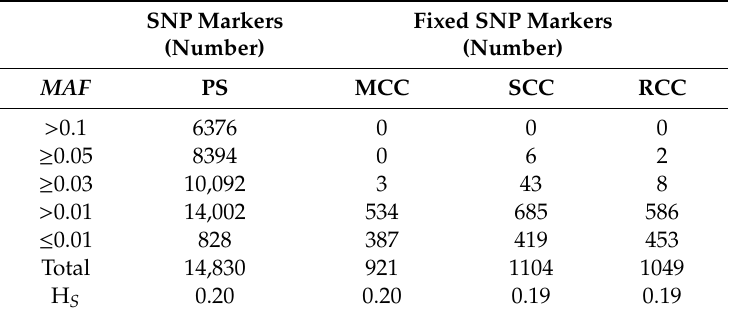
Table 5. Genetic diversity (H s ) and distribution of minor allele frequency (MAF) for the SNP (Single Nucleotide Polymorphisms) markers in the primary set and those fixed in the core collections. SNP Markers (Number)